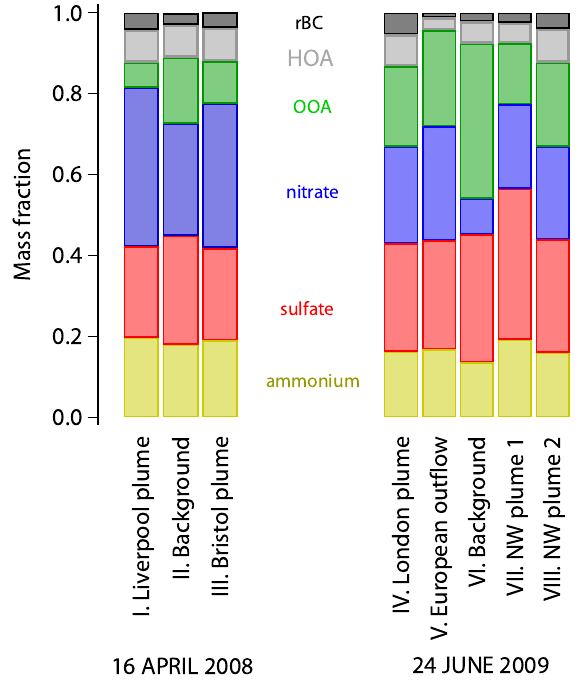
Fig. 5. Mass concentrations and mass fractions of rBC, HOA, OOA, nitrate, sulfate and ammonium averaged over different regions of the 16 April 2008 and 24 June 2009 flights shown in Figure